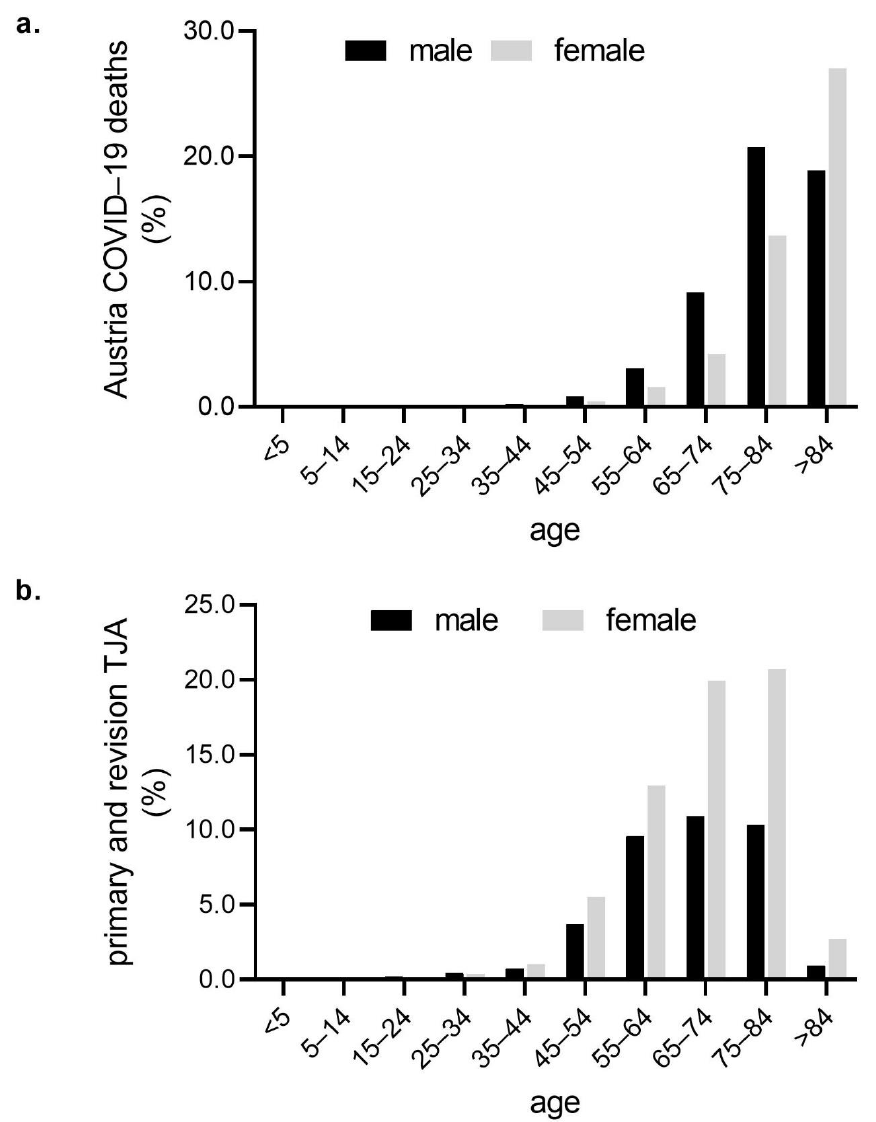
Figure 2. COVID-19 deaths and relative number of performed primary and revision total joint arthroplasties (TJAs). ( a ): Relative number of COVID-19 deaths in Austria per age group. ( b ): Relative number of primary and revision total joint arthroplasties (TJAs) per age group.